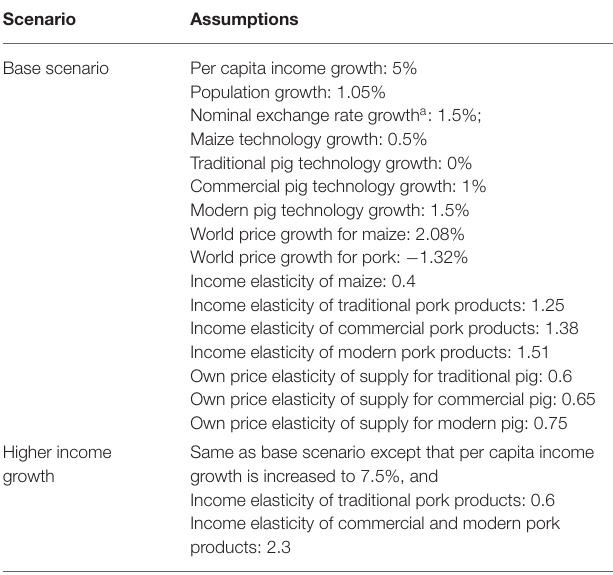
TABLE 2 | Summary of assumptions used in the base scenario and alternative scenarios simulated in VPM. Scenario